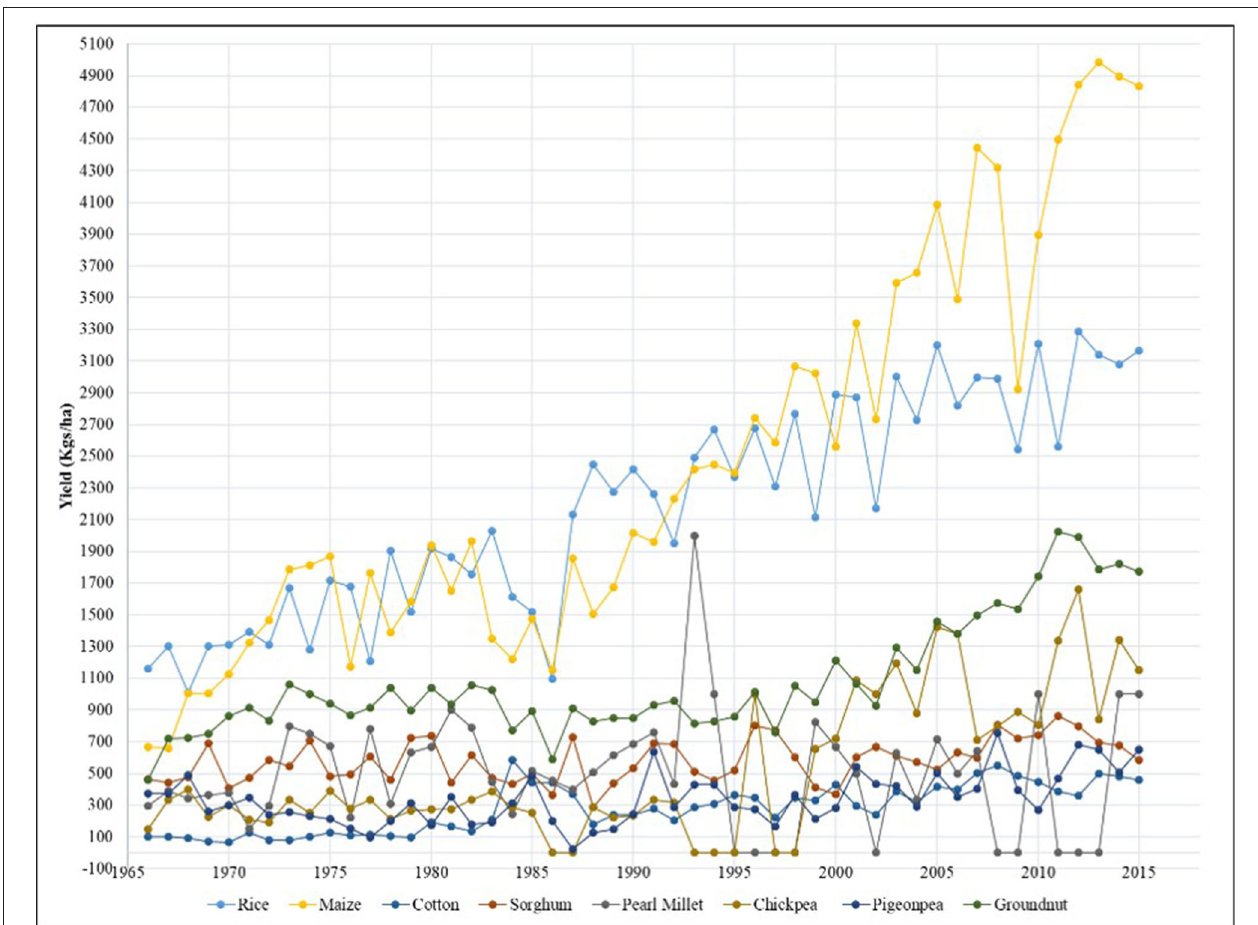
FIGURE 2 | Yield of paddy, maize, and other major crops over time in the study region.